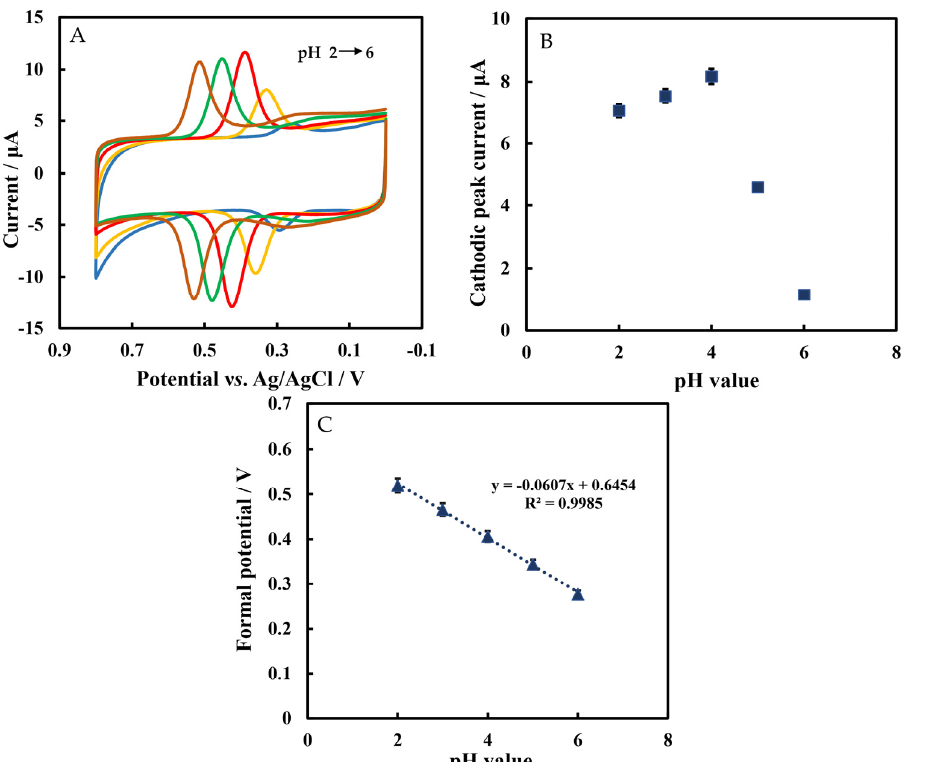
Figure 6. ( A ) The CVs of Chi/HFs − Lac/MWCNTs − CTAB/GCE in 50 mmol L − 1 phosphate-buffered solution at different pH values containing 5 µ mol L − 1 rutin. ( B ) Plot of cathodic peak current versus pH value. ( C ) Plot of formal potential versus pH value.